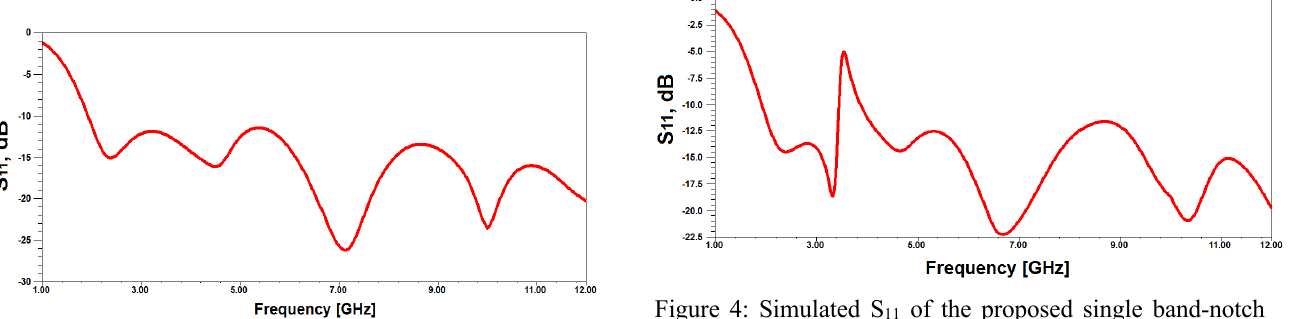
Figure 2: Simulated S 11 of the proposed UWB antenna.